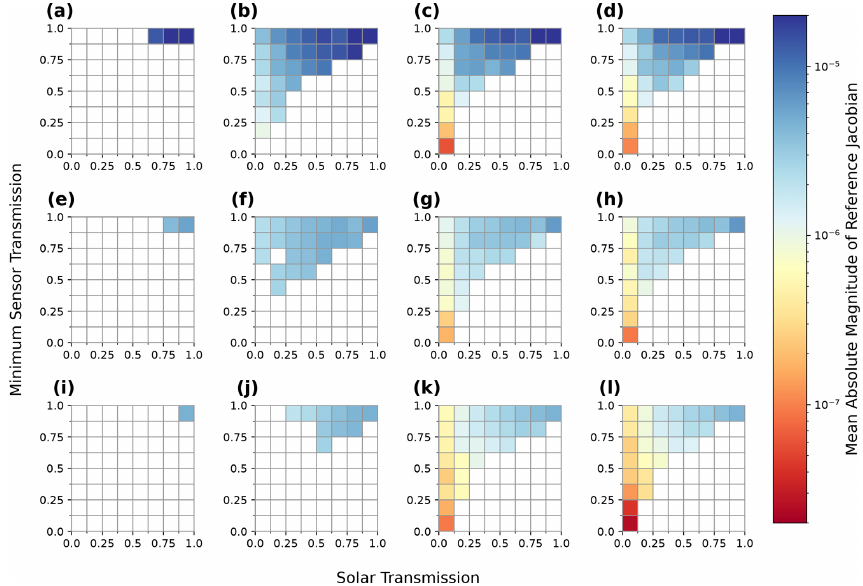
Figure 9. The mean absolute magnitude of finite-difference Jacobian for 3D Gaussian clouds in each bin of solar and minimum sensor delta- M transmission. Each column corresponds to a base state, with a maximum cloud optical depth from 0.1, 5.0, 40.0, and 100.0, increasing from left to right. Each row corresponds to a different combination of phase function and angular accuracy with isotropic phase function, Mie with full angular accuracy, and Mie with a reduced angular accuracy in descending order. All base states have a black surface with conservative